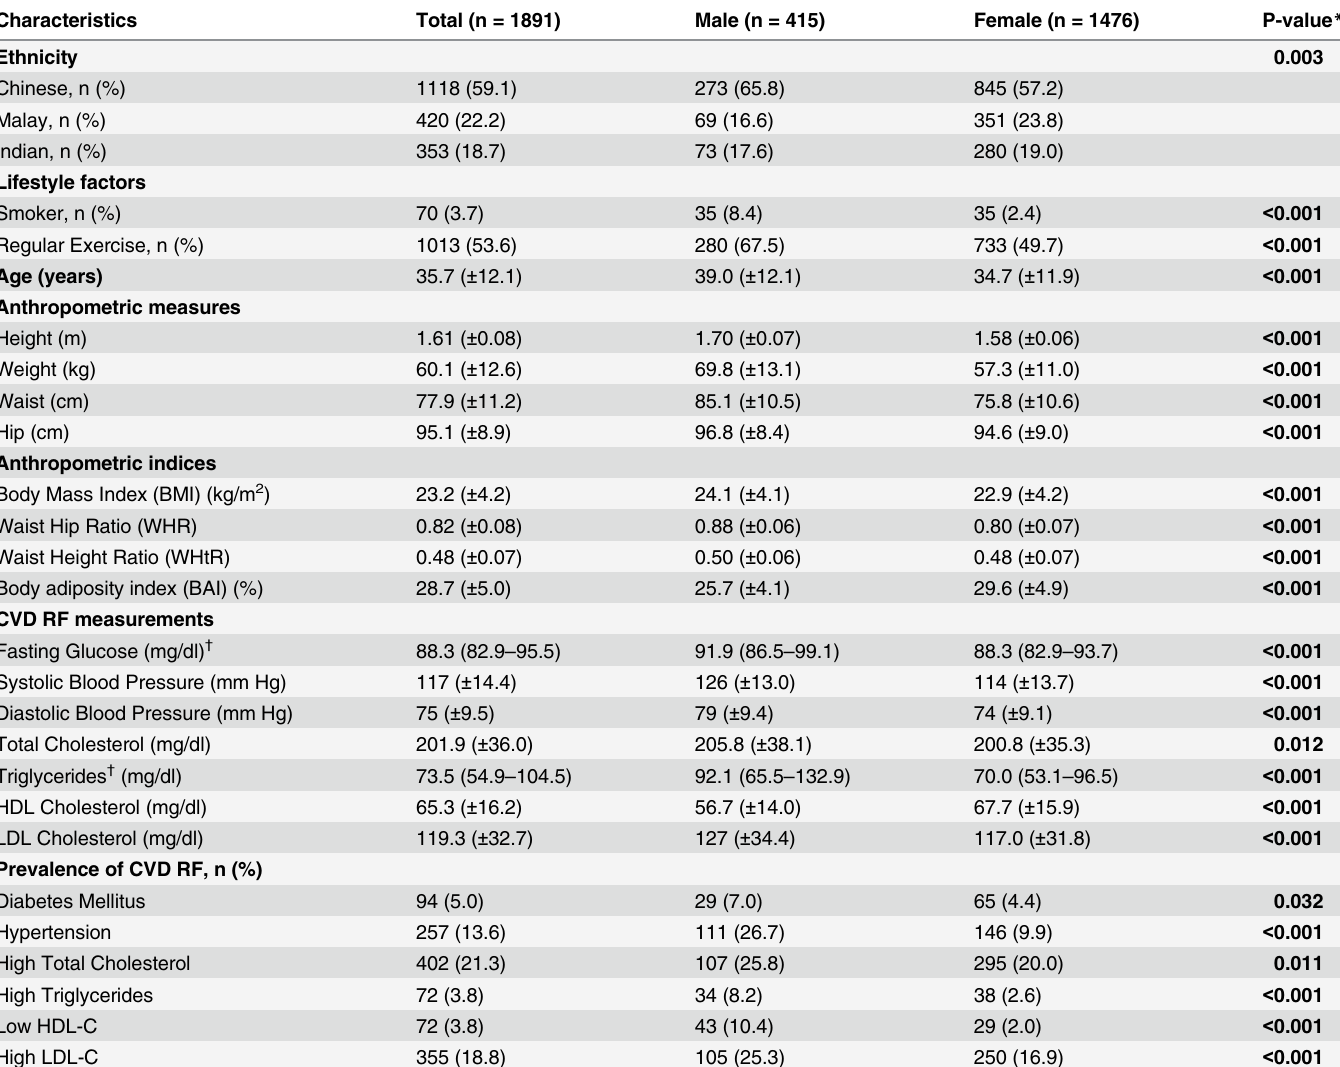
Table 1. Characteristics of study subjects.